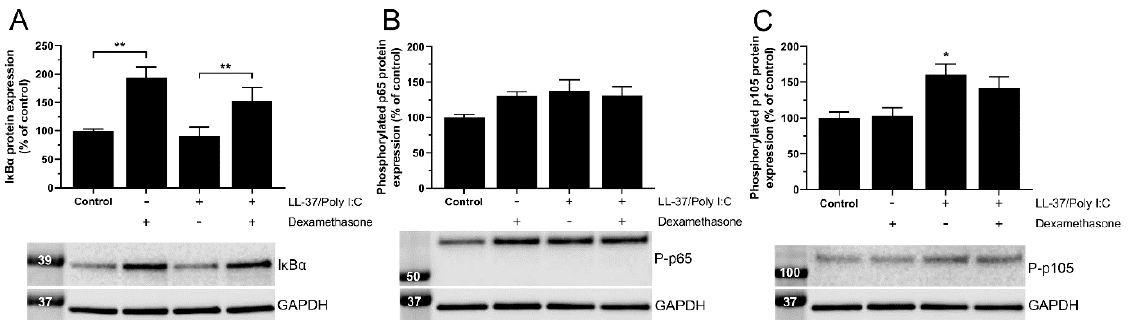
Figure 2. Dexamethasone reduces NF- κ B activity in BEAS-2B cells by increasing expression of I κ B α . ( A – C ) Western blot analysis of I κ B α ( A ), NF- κ B phosphorylated p65 ( B ) and NF- κ B phosphorylated p105 ( C ) was performed in cells stimulated with or without poly I:C (10 µg/mL) and LL-37 (1 µM) in combination in the presence or absence of dexamethasone (1 µM) for 24 h. The immunoreactive bands were observed at the expected molecular weight of 39 kDa (I κ B α ), 65 kDa (phosphorylated p65) and 105 kDa (phosphorylated p105), and the intensity of each band was normalized to GAPDH (37 kDa), serving as internal control. Data are presented as mean ± SEM, n = 7–8 in each group. Statistical significance was calculated using a one-way ANOVA followed by Tukey’s post hoc test. * represents p < 0.05 vs. control. For comparisons indicated by the bars, ** represents p < 0.01.